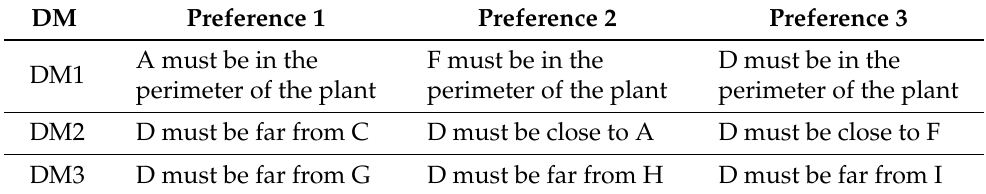
Figure 5. Material flow requirements for the CartonPacks problem. Table 5. DMs’ particular preferences for CartonPacks